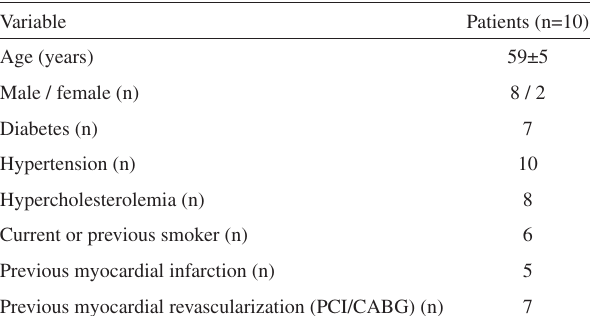
Table 1 - Clinical characteristics of enrolled